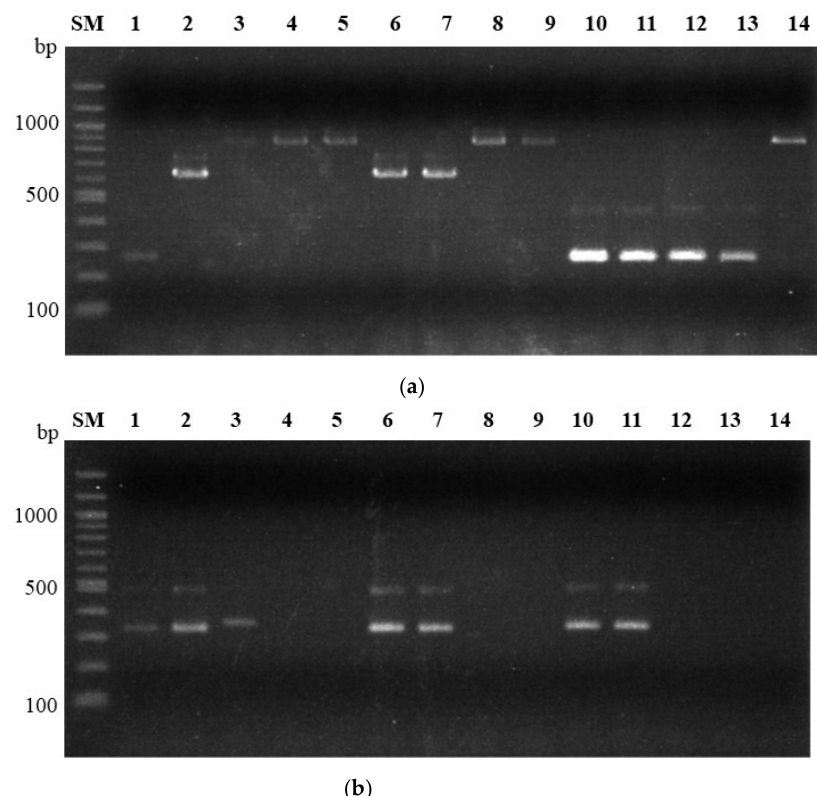
Figure 3. Multiplex PCR for trichothecene typing and species identification of Fusarium spp. Mul-